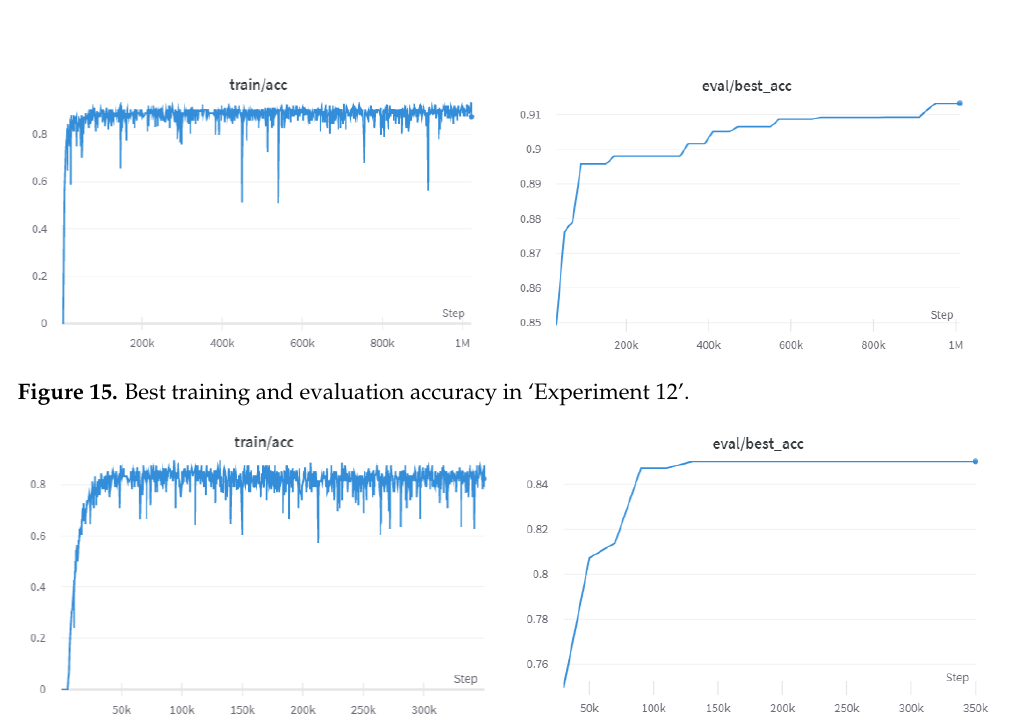
Figure 16. Best training and evaluation accuracy in ‘Experiment 13’. Figure 17 represents the training results of ‘Experiment 11’ (5M_enhujp_v2_4), ‘Experiment